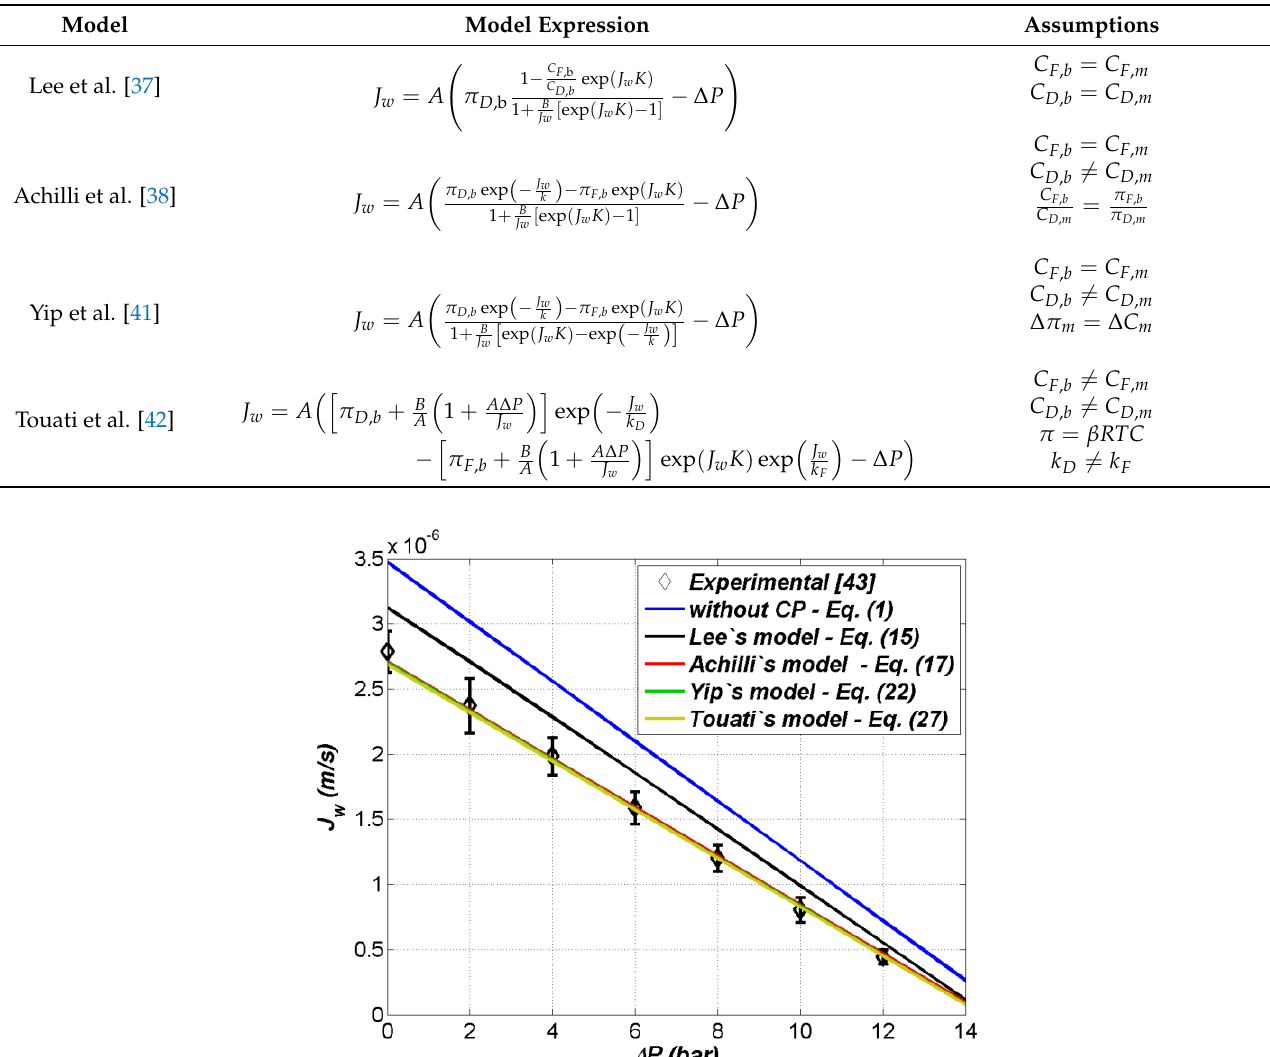
Table 1. Solution diffusion model development.